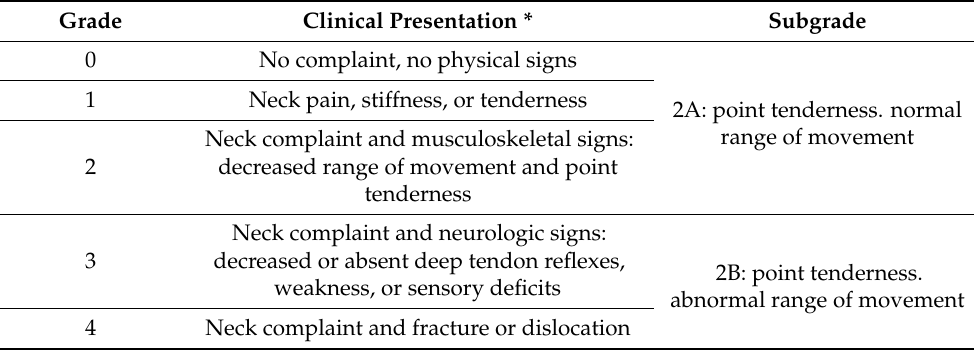
Table 1. Clinical classification of whiplash-associated disorders. Grade Clinical Presentation * Subgrade 0 No complaint, no physical signs movement1 Neck pain, stiffness, or tenderness 2A: point tenderness. normal range of Neck complaint and musculoskeletal signs: 2 decreased range of movement and point tenderness Neck complaint and neurologic signs: 3 decreased or absent deep tendon reflexes, 2B: point tenderness. weakness, or sensory deficits abnormal range of movement 4 Neck complaint and fracture or